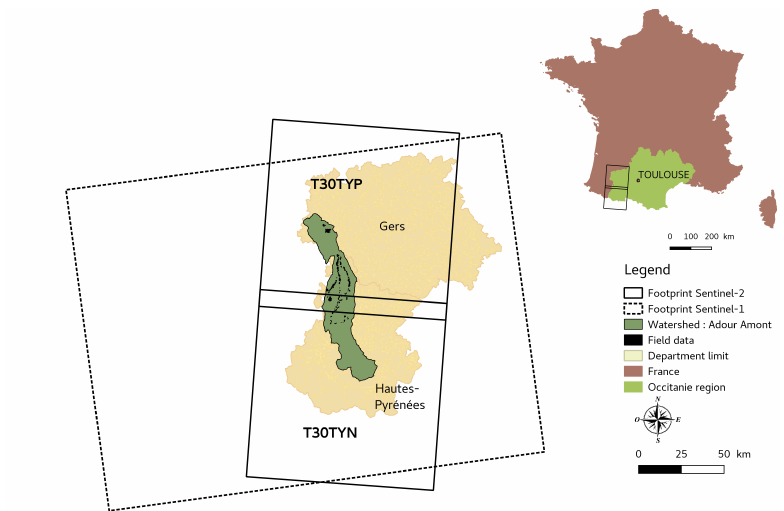
Figure 1. Location of the study area with footprints of the Sentinel-1, Sentinel-2 images and field data. Table 1. Theoretical cropping calendar of the studied summer crops: the green squares illustrate the theoretical period when the crop is sown, and the brown squares illustrate the period when the crop is harvested.